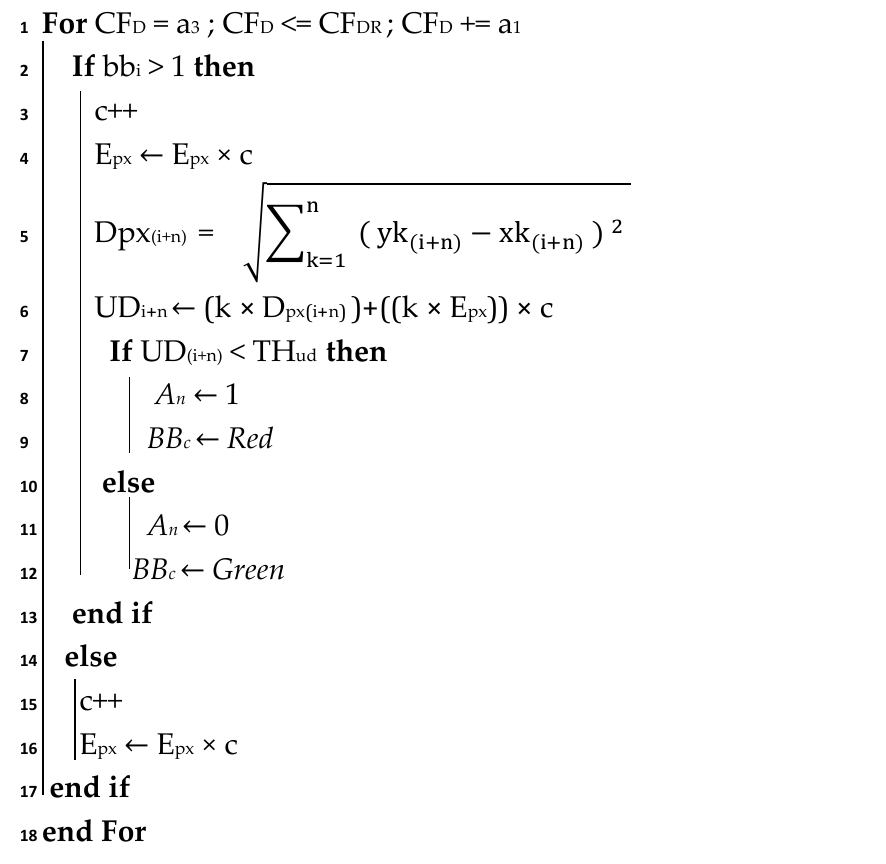
Algorithm 3: Monitoring people up to CF DR